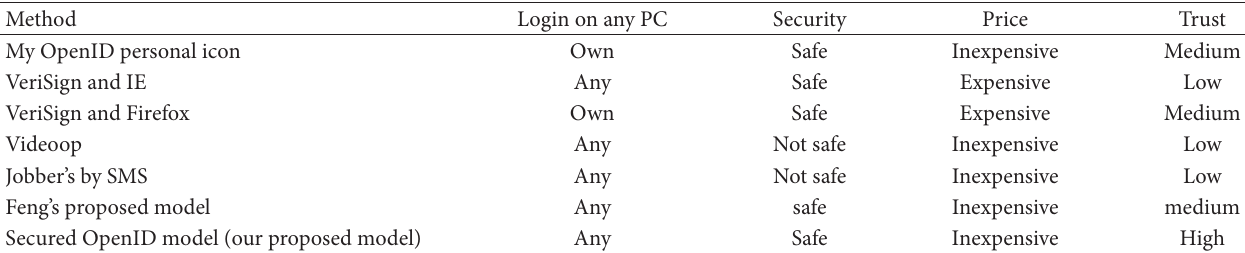
Table 2: Feature comparison of existing